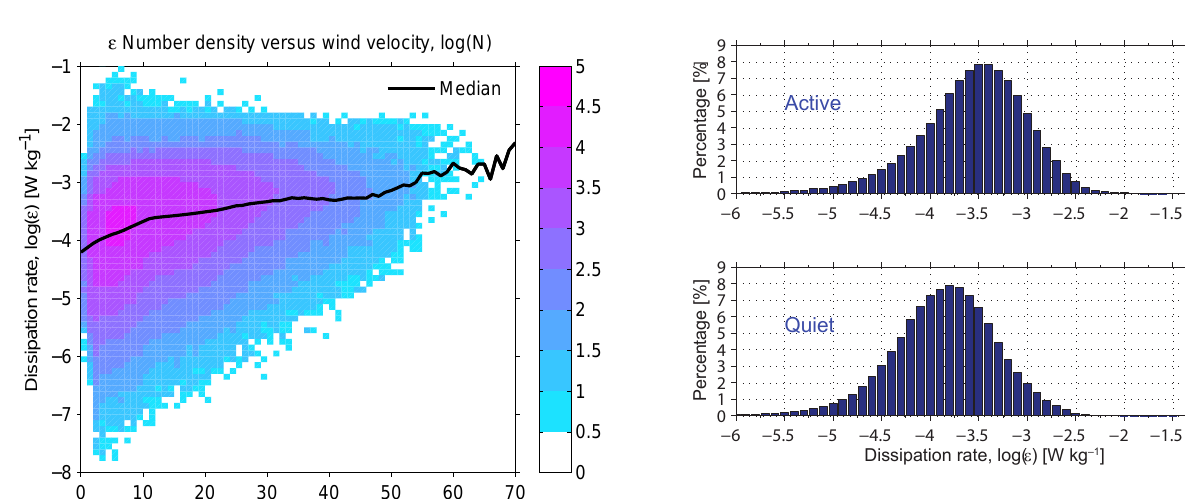
Figure 14. Histograms of the derived turbulent energy dissipation rates ε from the radar measurements with MAARSY in the years of 2010–2013 under active (upper panel) and quiet (lower panel) con- ditions. The ε values for both cases reveal a log-normal distribution as stated